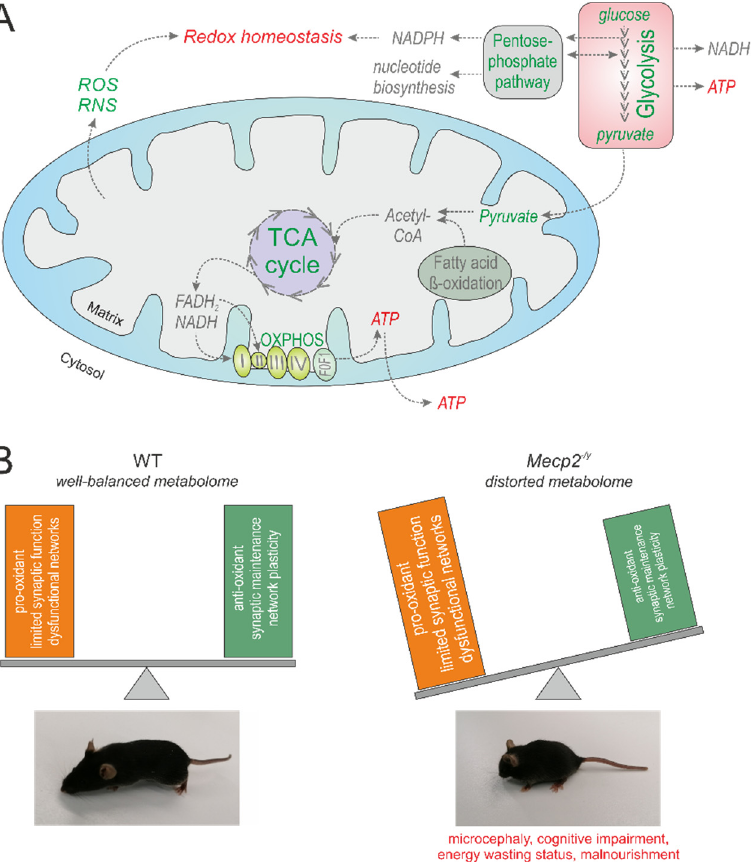
Figure 6. Multi-facetted metabolic derangements in the Mecp2-deficient mouse cortex. The central biochemical pathways that have been identified to be significantly altered by our unsupervised metabolomics analysis are outlined. Green font indicates upregulation, and red the downregulation and disturbance ( A ). It can be assumed that the entity of affected metabolites contributes to the characteristic features of RTT, which have been characterized in detail in numerous earlier studies. For example, this may include provoking a cellular redox imbalance with pro-oxidant conditions, facilitating conditions that limit synaptic function and network plasticity, and promoting an energy wasting status ( B ).